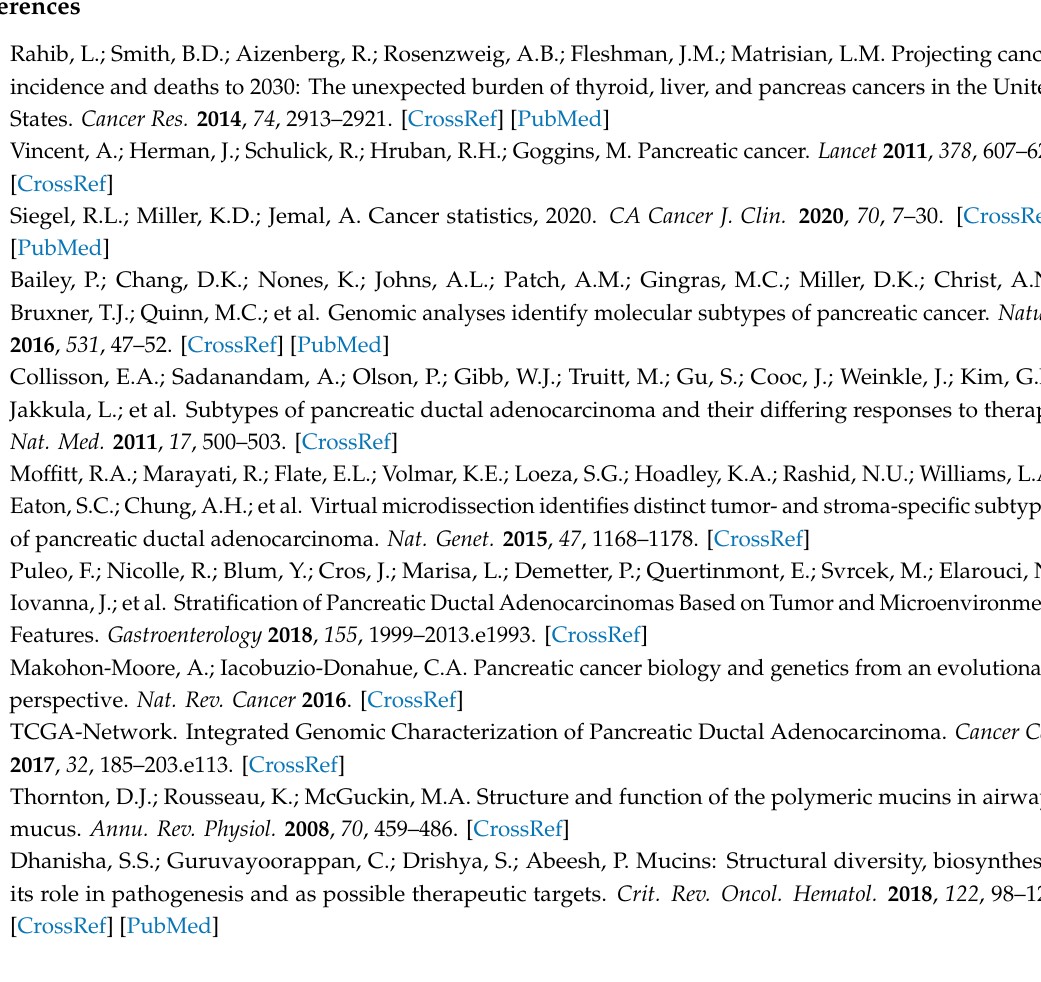
Figure S1. Mucin mRNA level in human tumor (T) and adjacent nontumor (ANT) tissues; Figure S2. Mucin mRNA levels and hazard ratio in pancreatic adenocarcinoma PAAD and GSE57495 cohorts; Figure S3. Analysis of overall survival and gene mutation in PAAD-TCGA patients with alterations of mucin genes; Figure S4. Correlation analysis of relative mucin mRNA levels in independent QCMG pancreatic adenocarcinoma dataset, Figure S5. Analysis of overall survival of the #1 and #2 mucin signatures in pancreatic cancer datasets using PROGgeneV2, Table S1. Correlation of mucin gene expression in pancreatic adenocarcinoma QCMG dataset ( p < 0.05). A total of 96 mRNA transcriptome samples were available. The R script is publicly available at https: // github.com / NicolasJonckheere / Mucin-script, The csv files and R script are available as supplemental materials (R script and csv files for MUCINS PAAD.zip file). All data are available and are based upon public